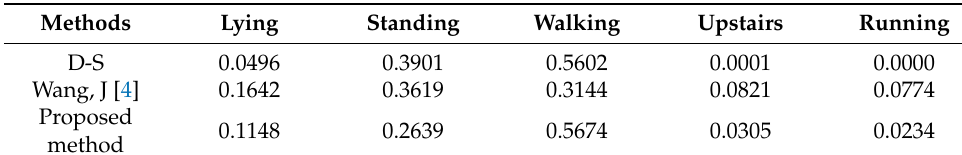
Table 5. Comparison of fusion results.